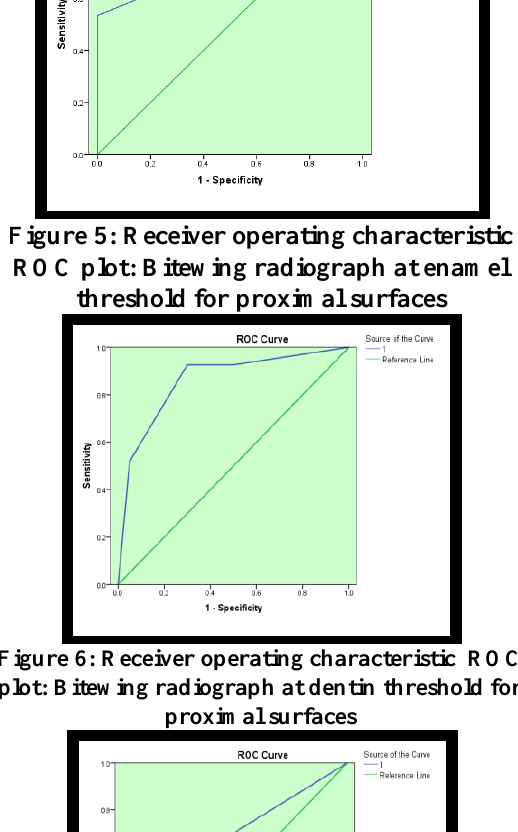
Figure 5: Receiver operating characteristic ROC plot: Bitewing radiograph at enamel threshold for proximal surfaces